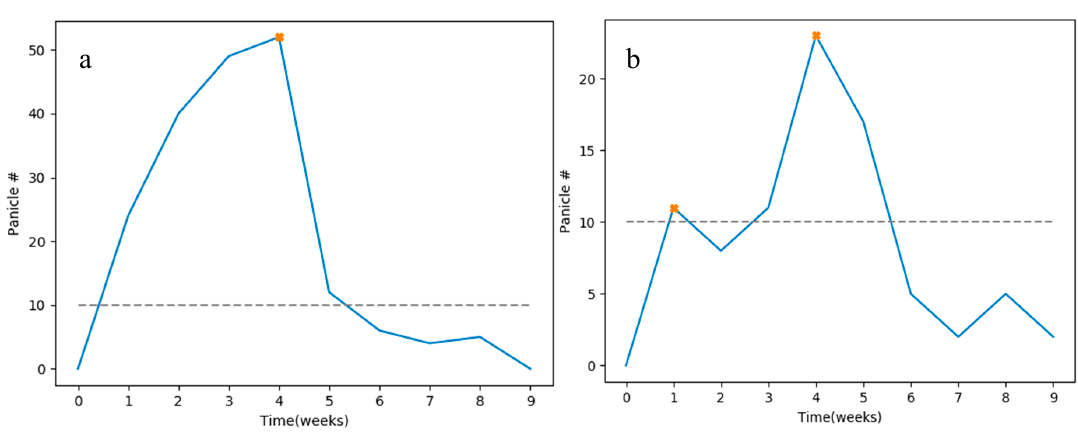
Figure 12. Flowering event detection on stage-X panicle counts for two different trees across 9 weeks of imaging. ( a ) Single peak and ( b ) double peaks marked with a coloured dot.